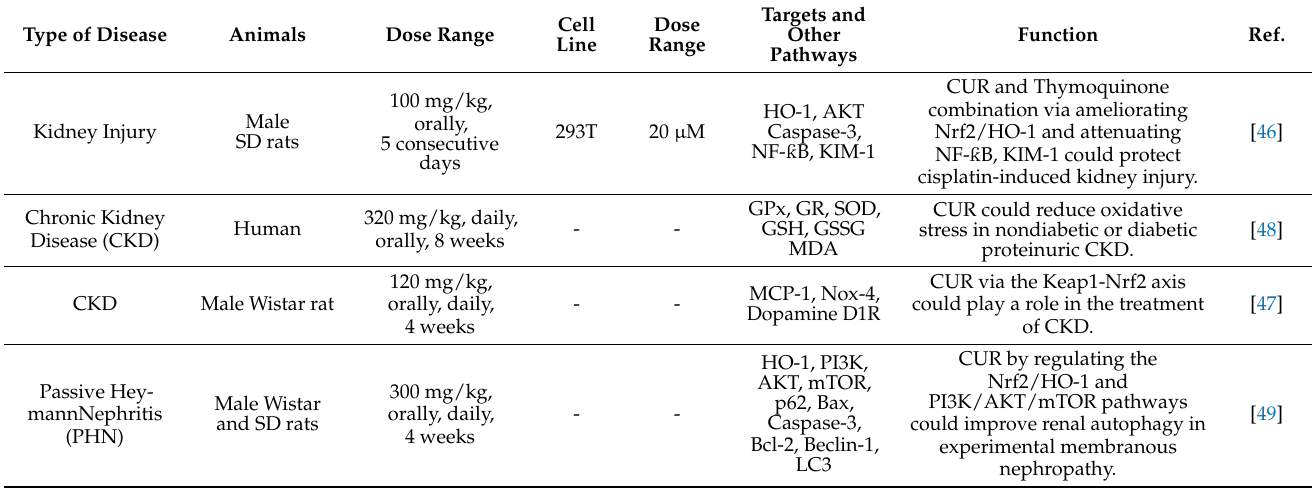
Table 5. Nrf2-related therapeutic effects of curcumin in renal